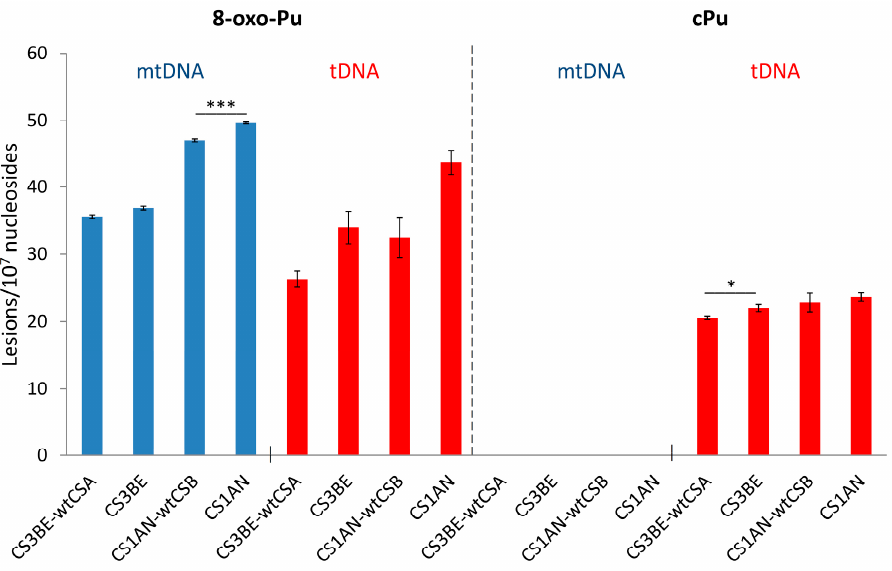
Figure 4. Comparison between 8–oxo–Pu and cPu lesions in the mtDNA and tDNA samples. The levels (lesions/10 7 Nu) of 8–oxo–Pu and cPu lesions in mtDNA (blue) and tDNA (red) extracted from CS1AN–wtCSB, CS1AN, CS3BE–wtCSA, and CS3BE cells. The error bars represent the standard deviation of the mean, calculated from three independent samples, * denotes a statistically significant difference ( p < 0.05) between the groups, *** denotes a statistically significant difference ( p < 0.001) between the groups (see Table S3).